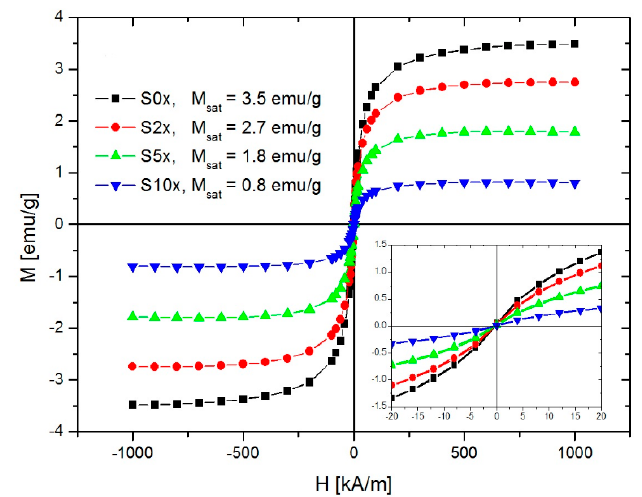
Figure 12. Magnetization plots of the magnetic papers having variable magnetic loadings.